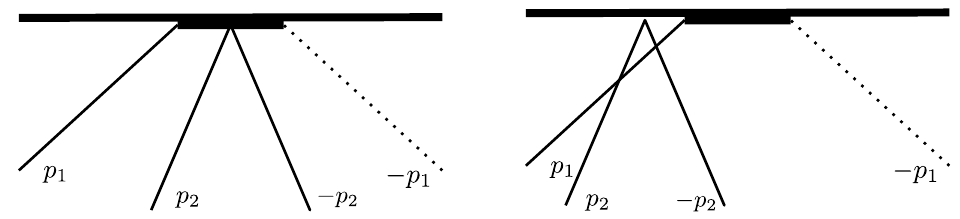
Figure 1 . Boundary bootstrap for the K-matrix (boundary state). Trajectories can be shifted allowing to calculate the bound state K-matrix in terms of the groundstate one and scattering